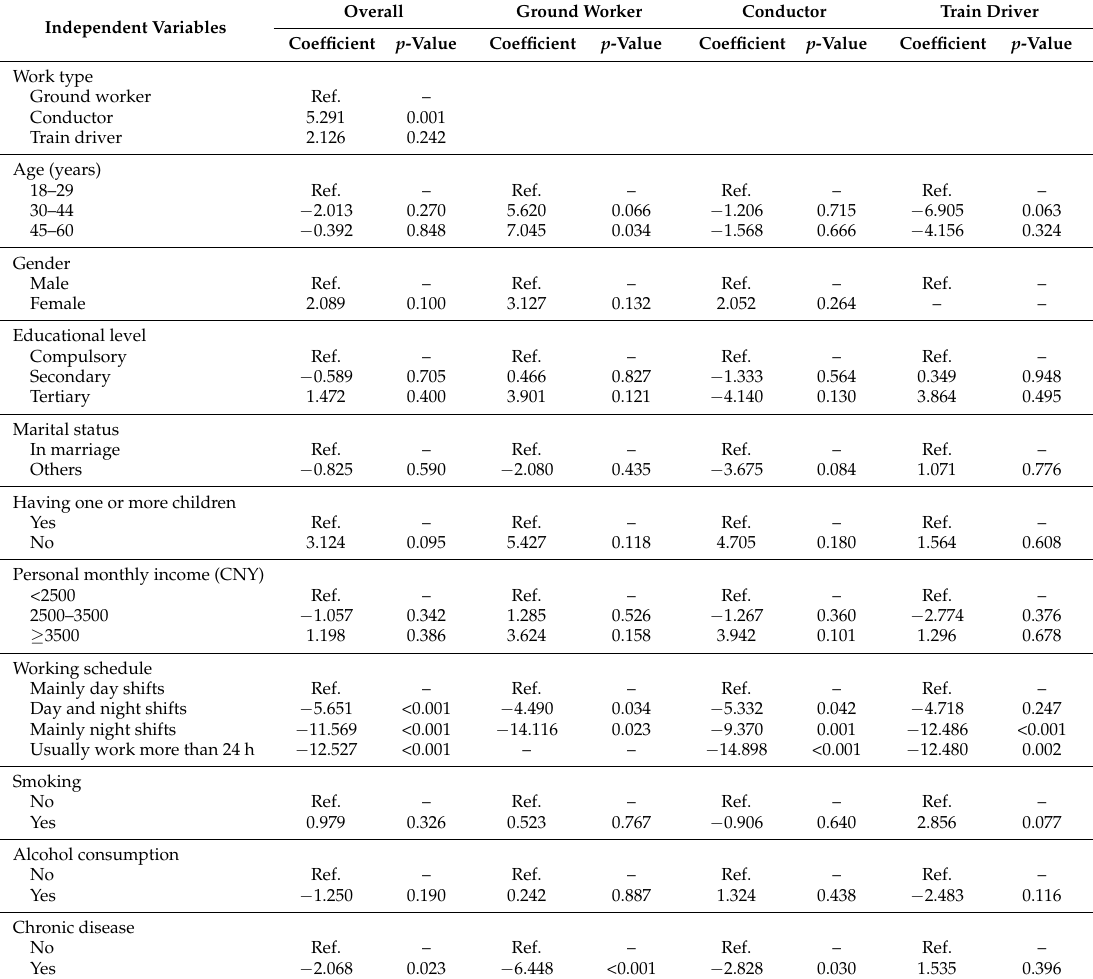
Table 3. Multivariable linear regression on mental component summary scores of SF-36v2 #